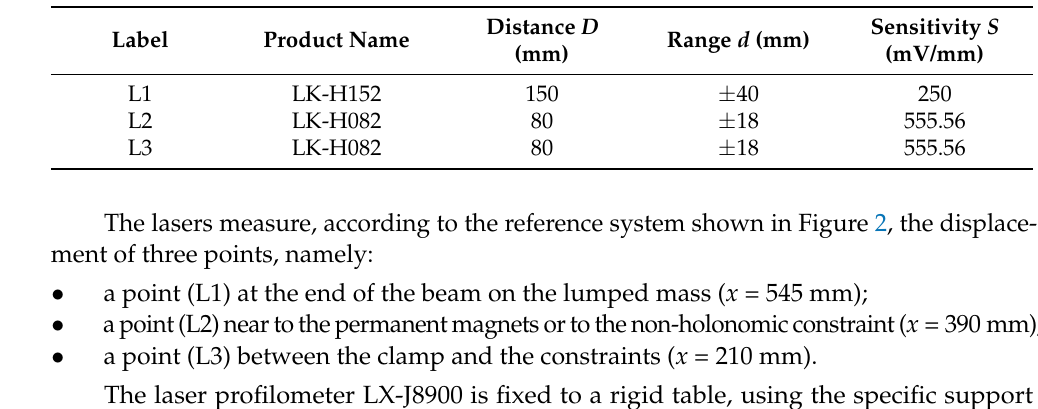
Table 2. Point-laser characteristics.